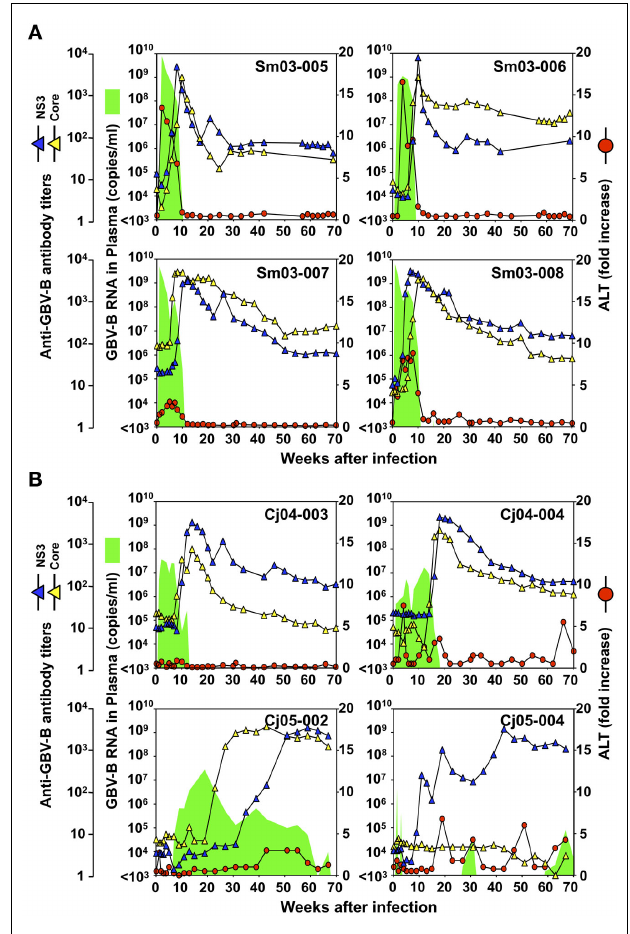
FIGURE 1 | Infection profiles until week 70 p.i. of tamarins (A) and marmosets (B) inoculated intrahepatically with GBV-B infectious serum obtained from a tamarin. Plasma samples periodically obtained from the monkeys were evaluated for the copy numbers of GBV-B genomic RNA (green shaded area), ALT levels (red circles), and the antibody titers against GBV-B core and NS3 (blue and yellow triangles, respectively).